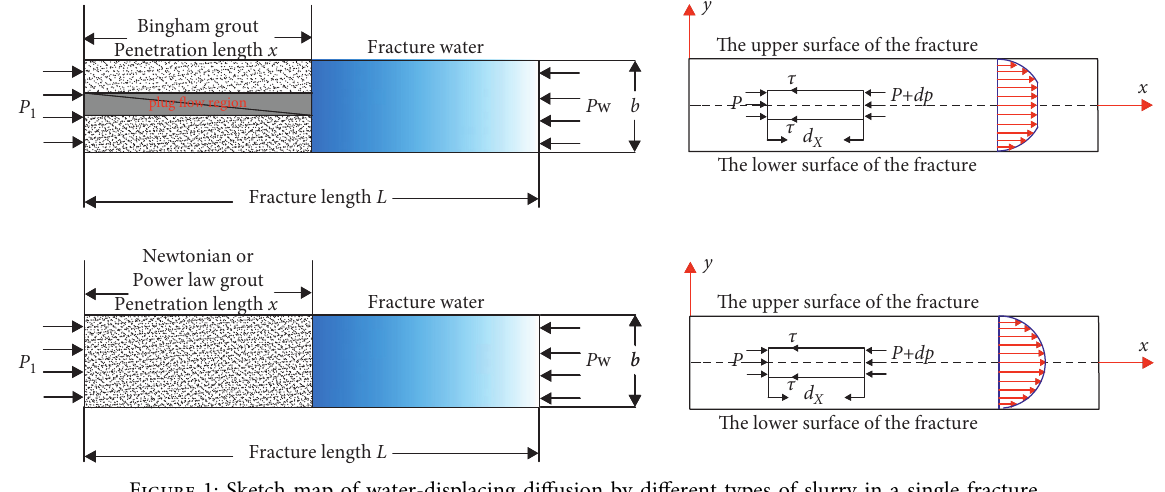
Figure 1: Sketch map of water-displacing diffusion by different types of slurry in a single